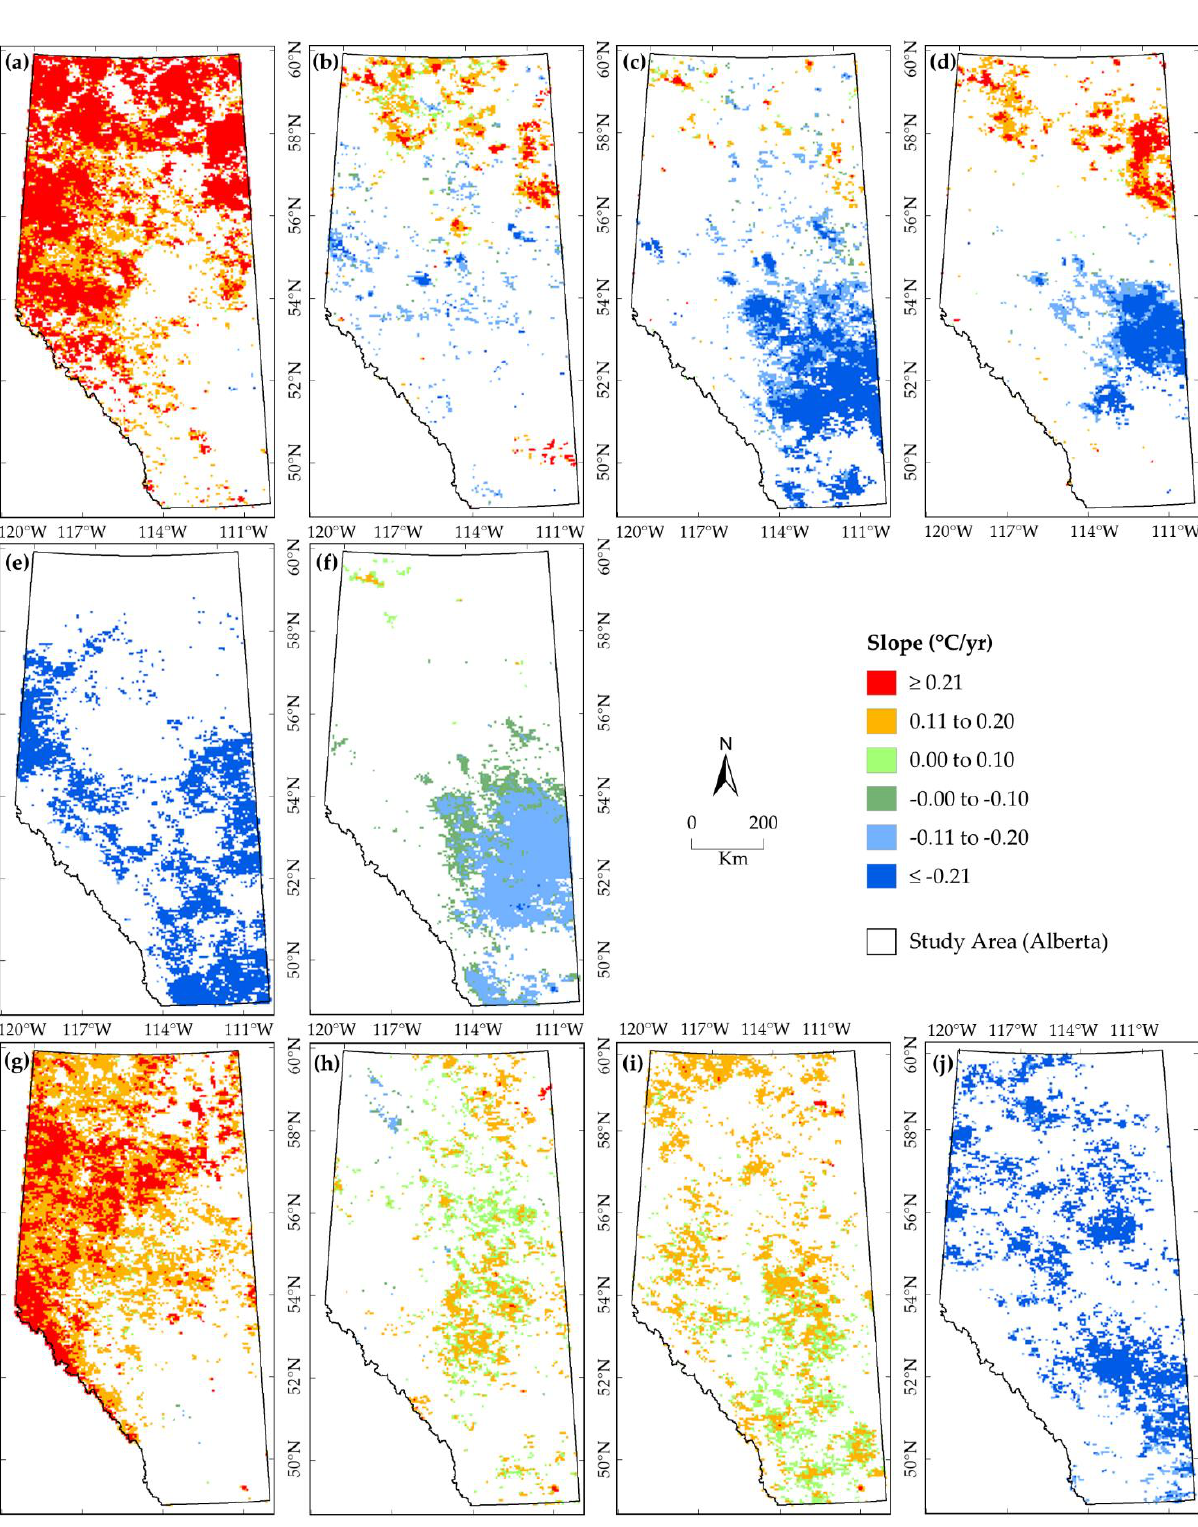
Figure 3. Spatial pattern of day and nighttime LST warming and cooling trends over 90% confidence levels. Daytime months are May ( a ), June ( b ), July ( c ), August ( d ), November ( e ), and annual ( f ); nighttime months are May ( g ), June ( h ), August ( i ), and November ( j ), where they showed trends in at least 10% area in Alberta.